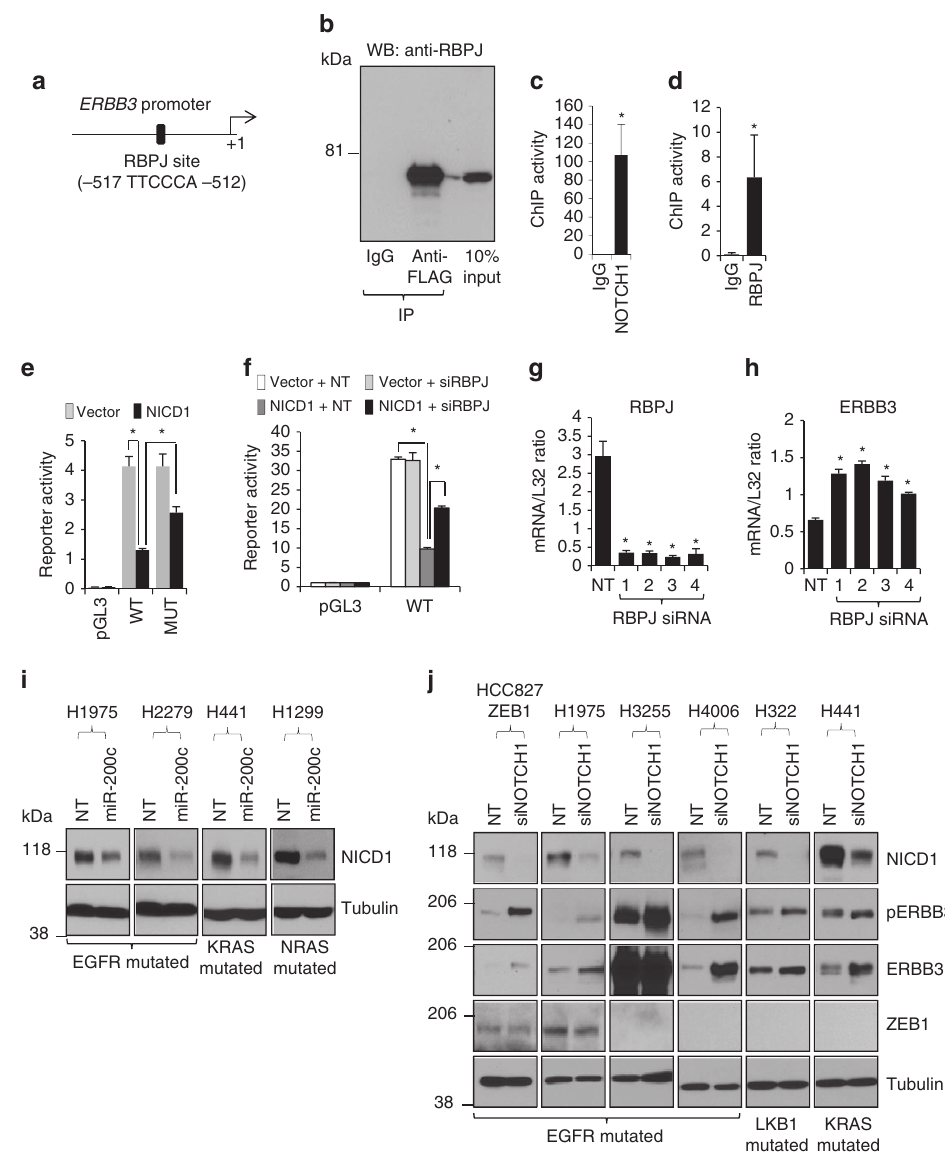
Figure 4 | NICD1 and RBPJ regulate ERBB3 promoter. ( a ) Schematic for the ERBB3 promoter containing a putative RBPJ-binding site. ( b ) Immunoprecipitation result showing NICD1 bound to RBPJ in H1299 lung cancer cells. H1299 cells were transiently transfected with FLAG-tagged NICD1, which were immunoprecipitated by anti-FLAG. Both IgG immunoprecipitates and 10% non-immunoprecipitated cell lysate were included in the RBPJ western blotting as controls. ChIP assays result showing that both NOTCH1 ( c ) and RBPJ ( d ) directly bound to the RBPJ site on ERBB3 promoter in H1299 cells (triplicates; mean plus s.d.). * indicates t -test P o 0.05. Mutation of the RBPJ binding site ( e ) or knockdown of RBPJ ( f ) suppressed the inhibitory effect of NICD1 on the ERBB3 promoter activity (triplicates; mean plus s.d.). * indicates t -test P o 0.05. qPCR of RBPJ ( g ) and ERBB3 ( h ) for H322 lung adenocarcinoma cells transfected with control NTnon-targeting siRNA or RBPJ siRNAs (triplicates; mean plus s.d.). * indicates t -test P o 0.05. ( i ) Western blotting of NICD1 and Tubulin for lung cancer cells transiently transfected with miR-200c or a control non-targeting microRNA (NT). ( j ) Western blotting of ZEB1, NICD1, pERBB3, ERBB3 and Tubulin for lung cancer cells transiently transfected with NOTCH1 siRNA or a control non-targeting siRNA